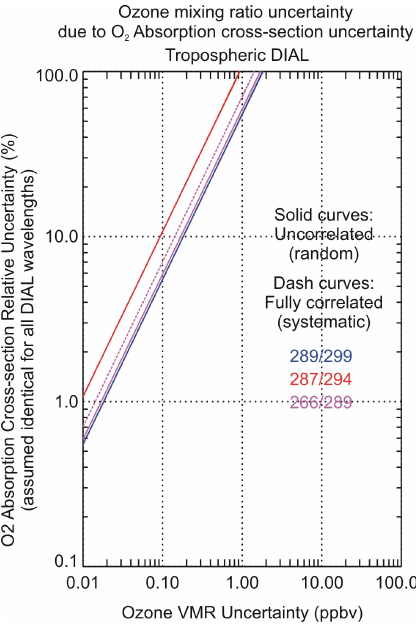
Figure 11. Ozone mixing ratio uncertainty as a function of O 2 cross section relative uncertainty (%), assuming that all cross sections used have the same relative uncertainty. Solid curves are used for cases of independent (random) cross section datasets, and dashed curves are used for the case of full correlation between all cross